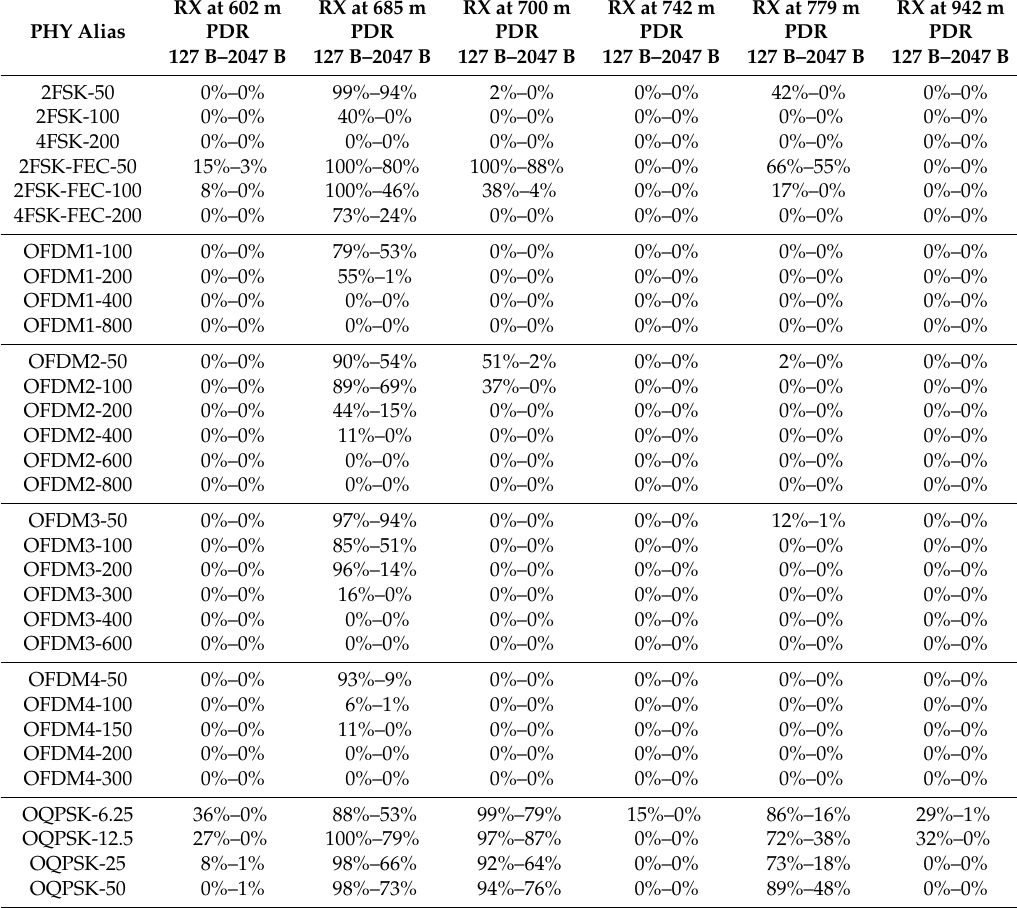
Table 10. Urban Canyon. PDR for packets of 127 B and 2047 B for each RX node for node locations from 602 m to 942 m The limit of the radio link is at 779